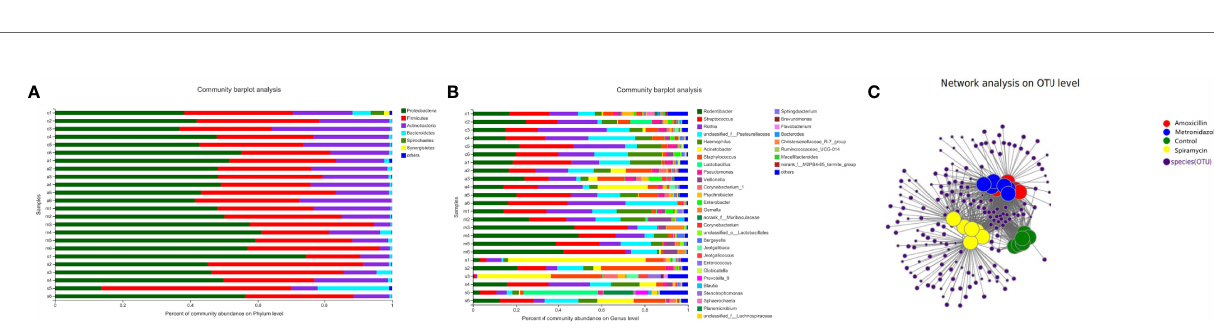
FIGURE 3 | (A) Bacterial community richness (measured by ACE index) in all the groups. (B) Bacterial community richness (measured by Chao index) in all groups. (C, D) Bacterial community diversity (measured by Shannon, Simpson index) in all the groups. Differences were considered statistically signi fi cant at *p < 0.05; **p < 0.01